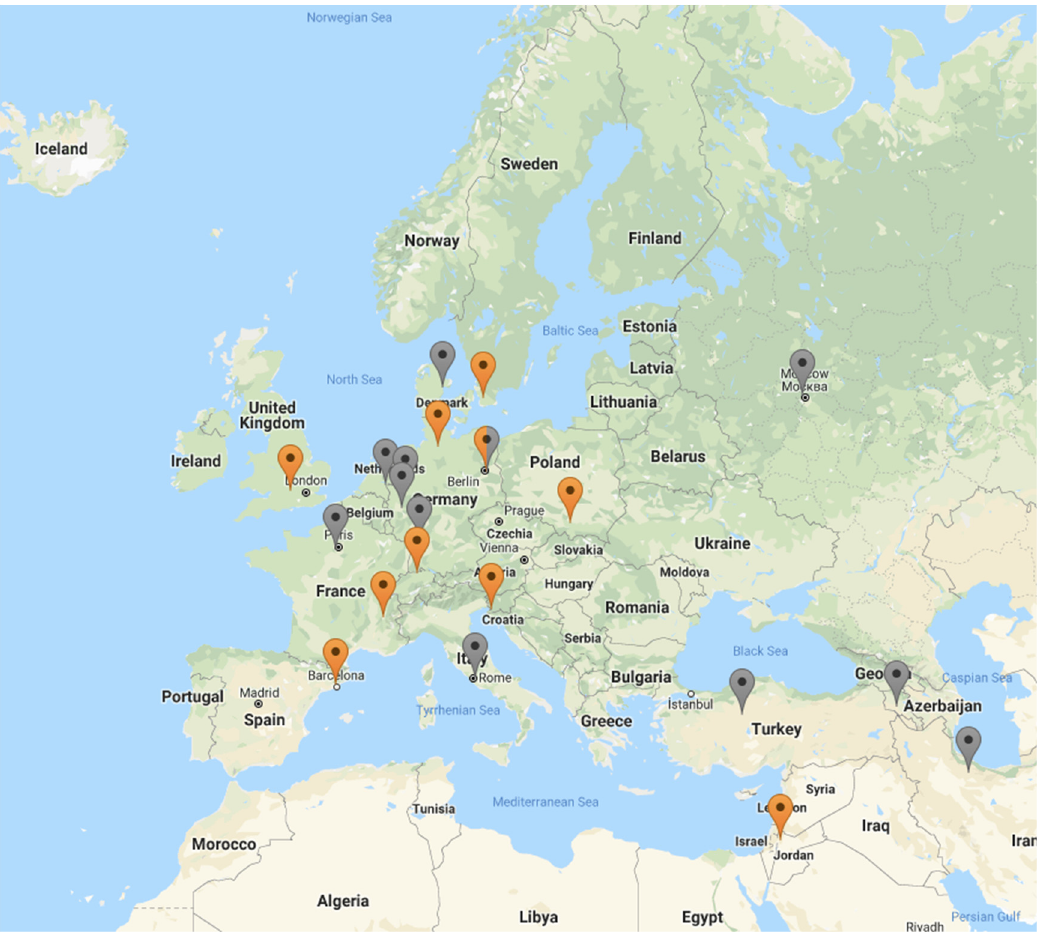
Figure 1. A map of existing or under construction Light Sources in Europe and surrounding areas (https://lightsources.org/lightsources-of-the-world/europe/).